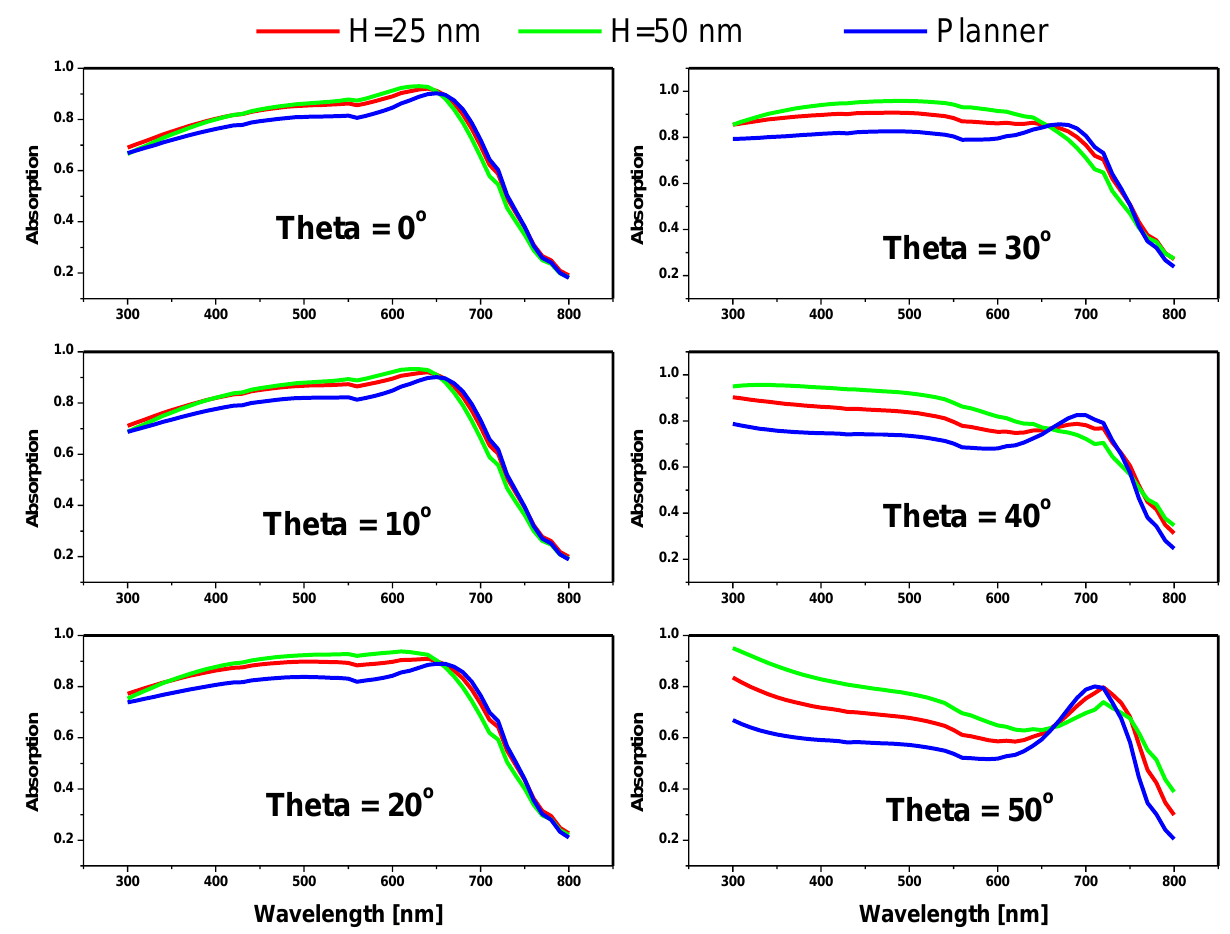
Figure 8. Hydrogenated amorphous silicon solar cell (a-Si: H) absorption spectrum with ternary anti-reflective coating with texturing on the top surface at different incident angles. The ternary ARC is composed of silicon nitride with a thickness of 33 nm immersed between silicon dioxide and titanium dioxide with a thickness of 54 nm and 82 nm, respectively. Also, the back reflector is composed of silicon dioxide and silicon, with thicknesses of 40 nm and 75 nm, respectively. The number of periods equals 12. These calculations are determined at the planner surface, a texturing surface with a height equal to 25 nm, and a texturing surface with height equal to 50 nm, as shown.